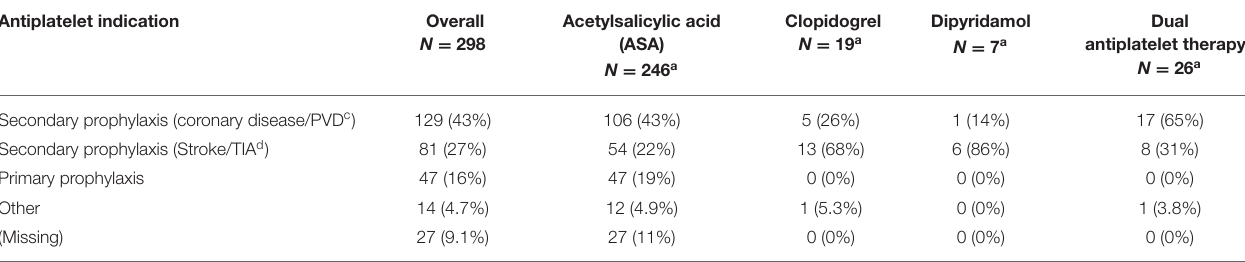
TABLE 3 | Indications for the use of platelet inhibitors.